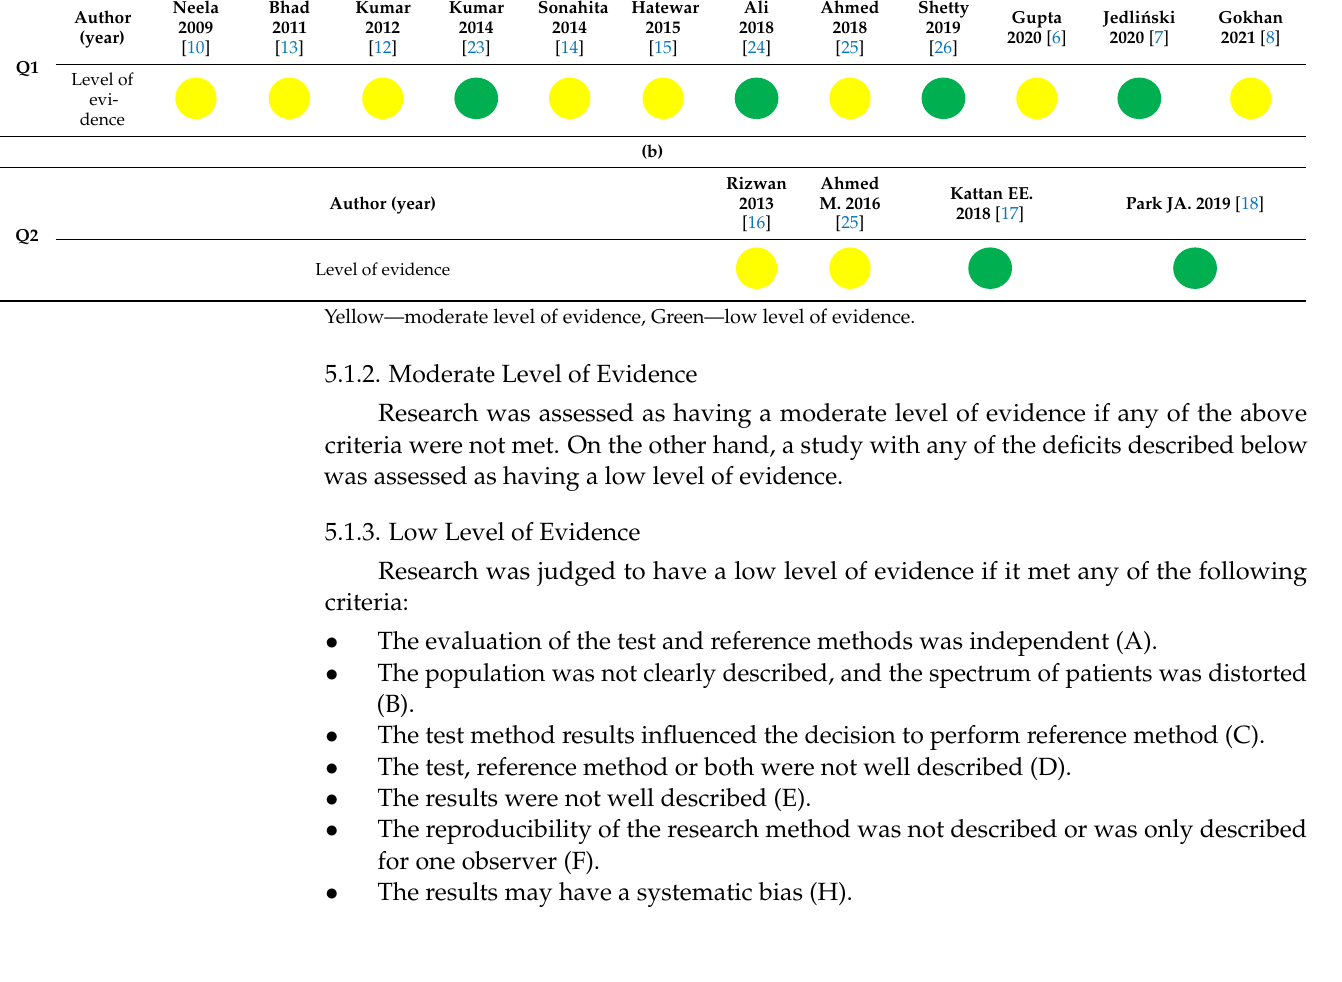
Table 3. (a) The evaluation of the conclusions according to the degree of evidence of articles discussing new indicators of cephalometric analysis in relation to the sagittal plane. (b) The evaluation of the conclusions by degree of evidence of articles discussing new indicators of cephalometric analysis in relation to the horizontal plane.